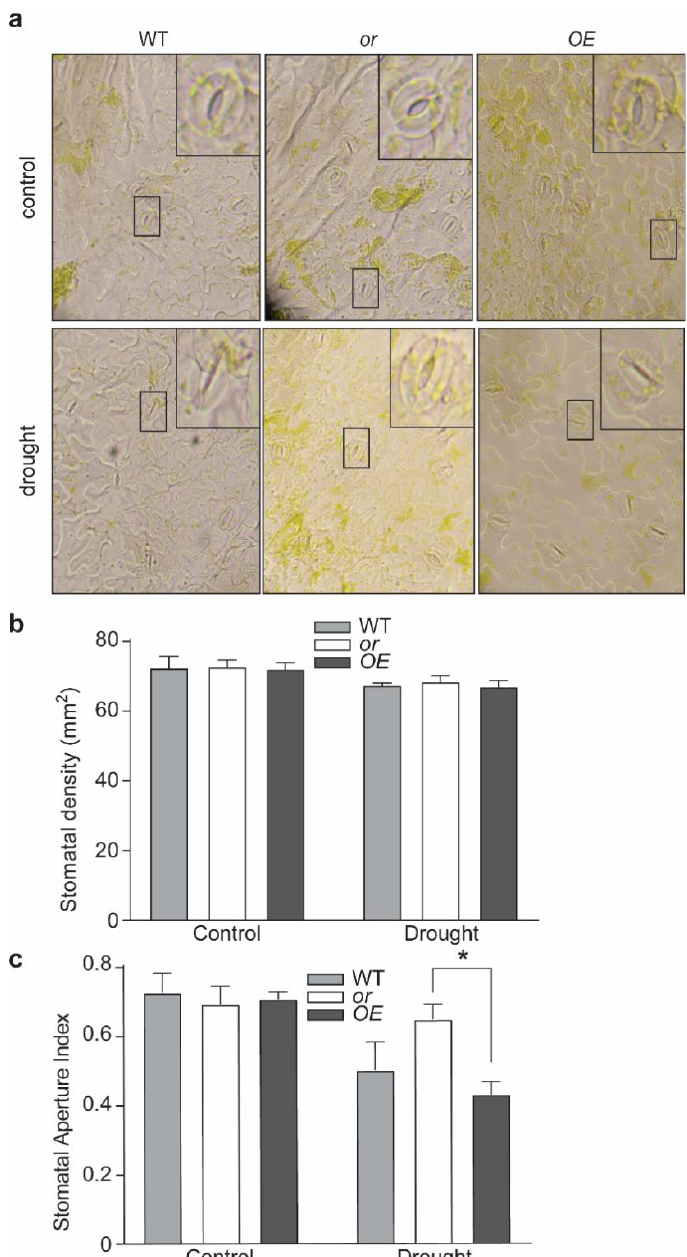
Figure 4. OR affects the response of stomatal apertures to drought stress. ( a ) Microscopic observa- tion of stromata from the wild-type (WT) and OR -overexpressing ( OE ) and -silencing ( or ) seedlings under normal growth (control) and drought treatment. ( b ) Stomatal densities of the WT, OE , and or lines. Data are means ± SEM ( n = 20). ( c ) Stomatal aperture index of different lines under normal growth conditions (control) and drought treatment. Data are means ± SEM ( n = 15) * p < 0.05, Student’s t test).